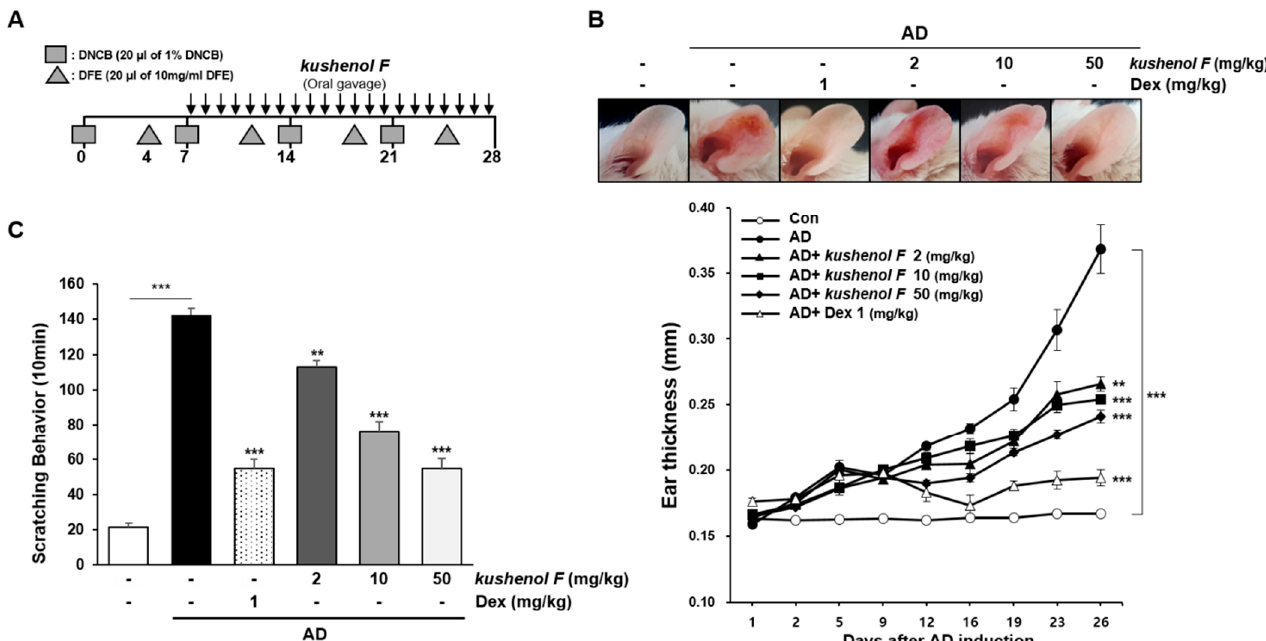
Figure 2. Kushenol F ameliorates clinical symptoms in AD mice. ( A ) Schematic diagram of the present study. DNCB was administered first and DFE was used 4 days later on each ear. DNCB or DFE treatment was repeated once a week rotationally for 4 weeks. After 1 week of induction, kushenol F (2, 10 or 50 mg/kg) was orally administered daily for 3 weeks. ( B ) Ear thickness was assessed 24 h following DFE or DNCB application with a dial thickness gauge. Representative photographed examples of the effects of kushenol F on DFE/DNCB-induced AD-like skin lesions in the ear. ( C ) Mouse scratching behavior of was assessed 4 h following the last sensitization for 10 min. Data are presented as the mean ± SD ( n = 5). ** p < 0.01 and *** p < 0.001 vs. control. AD, atopic dermatitis; DFE, Dermatophilosis farinae extract; DNCB, 1-chloro-2,4-dinitrochlorobenzene.